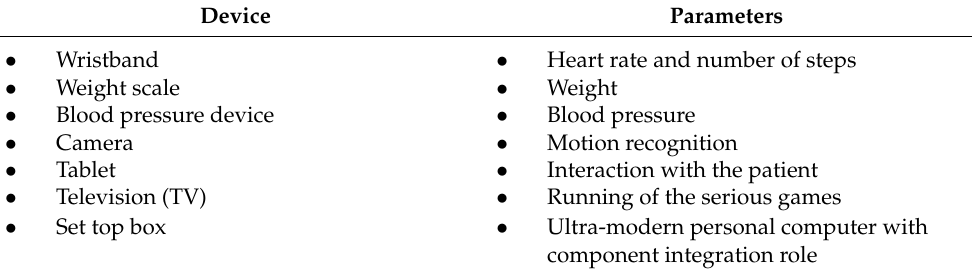
Table 4. Monitoring parameters of the devices used.